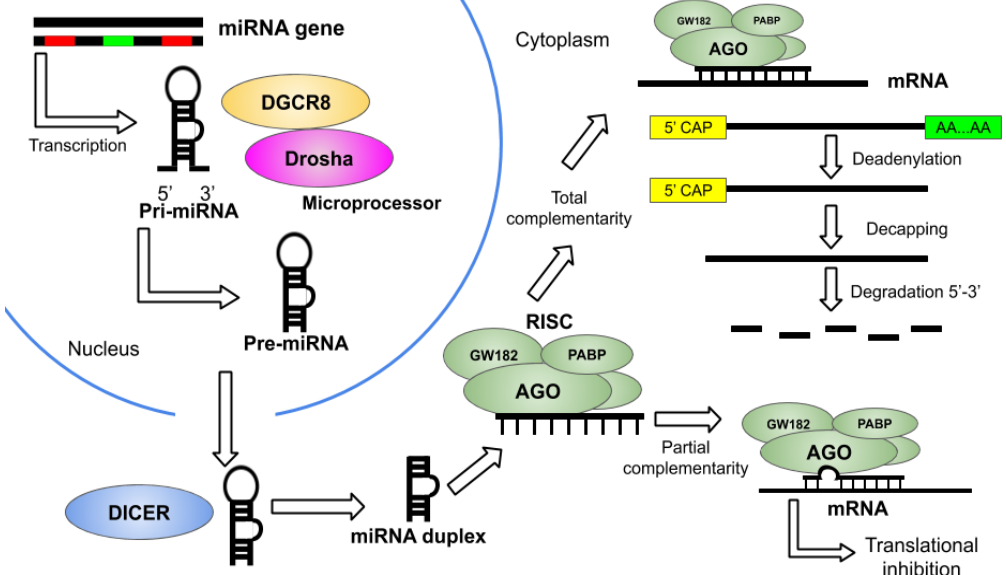
Figure 1. Scheme of miRNA biogenesis and the mode of action of RISC. The pri-miRNA is obtained in the nucleus by the translation of a specific gene and then transformed into pre-miRNA by the microprocessor complex conformed by DGCR8 and Drosha. Afterward, it is transported to the cytoplasm, where the DICER protein removes the loop of the molecule resulting in the miRNA duplex, thereafter, it joins the RISC by the AGO protein. When the RISC has total complementarity, the mRNA target is deadenylated, decapped, and completely degraded. Otherwise, partial complementarity can reduce or inhibit the translation and eventually cause mRNA degradation.